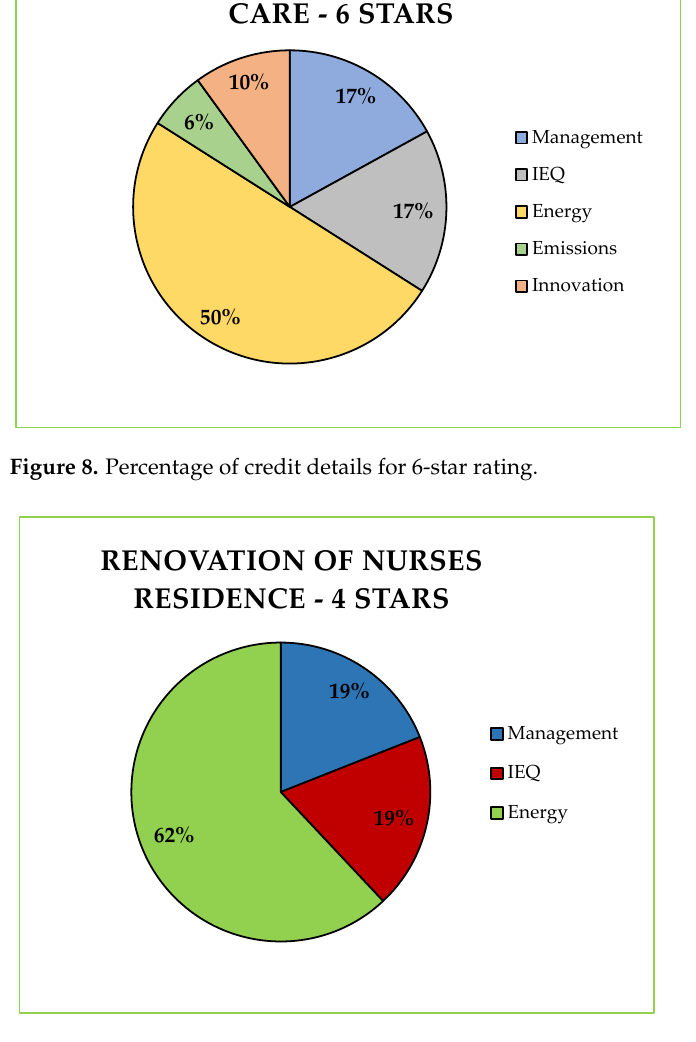
Figure 9. Percentage of credit details for 4-star rating.